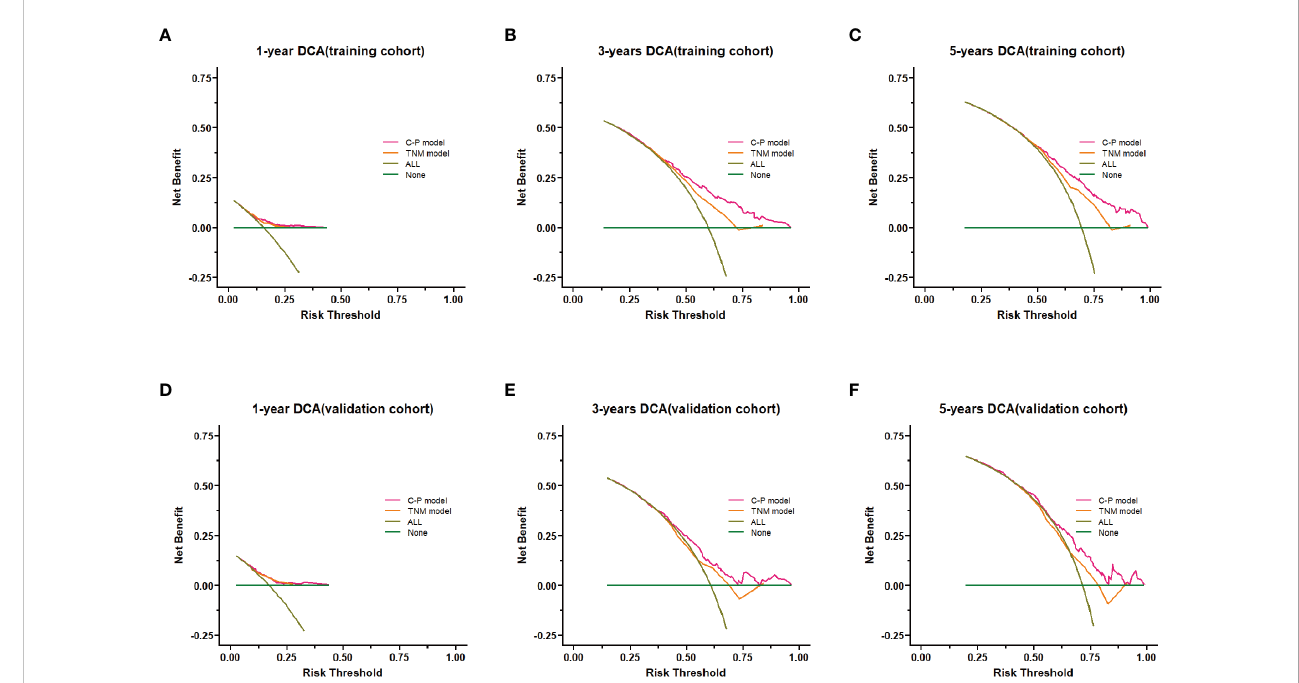
FIGURE 6 Decision curve analysis (DCA) of the nomogram model. (A – C) DCA curves of 1-,3- and 5-years survival prediction for the clinical-pathological nomogram model and the TNM stage nomogram model in the training cohort. (D – F) DCA curves of 1-,3- and 5-years survival predictions for the clinical-pathological